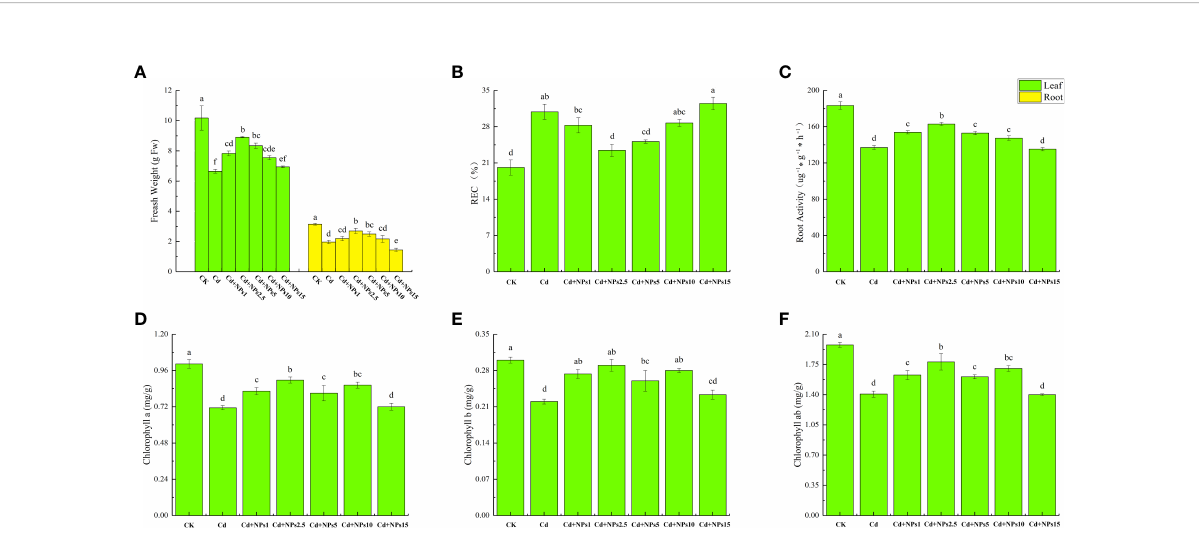
FIGURE 1 Effects of different concentrations of zinc oxide nanoparticles (ZnONPs) on biomass accumulation (A) , leaf relative electrical conductivity (REC) (B) , root activity (C) and chlorophyll content (D – F) in lettuce under cadmium (Cd) stress. CK, no treatment; Cd, exposed to 1 mg/l of Cd; Cd + 1 Nps, exposed to 1 mg/l of Cd and 1 mg/l of ZnONPs; Cd + 2.5 Nps, exposed to 1 mg/l of Cd and 2.5 mg/l of ZnONPs; Cd + 5 Nps, exposed to 1 mg/l of Cd and 5 mg/l of ZnONPs; Cd + 10 Nps, exposed to 1 mg/l of Cd and 10 mg/l of ZnONPs; Cd + 15 Nps, exposed to 1 mg/l of Cd and 15 mg/l of ZnONPs. Data are shown as means ± SE of three replicates. Bars marked by different letters indicate signi fi cant differences according to Duncan ’ s test